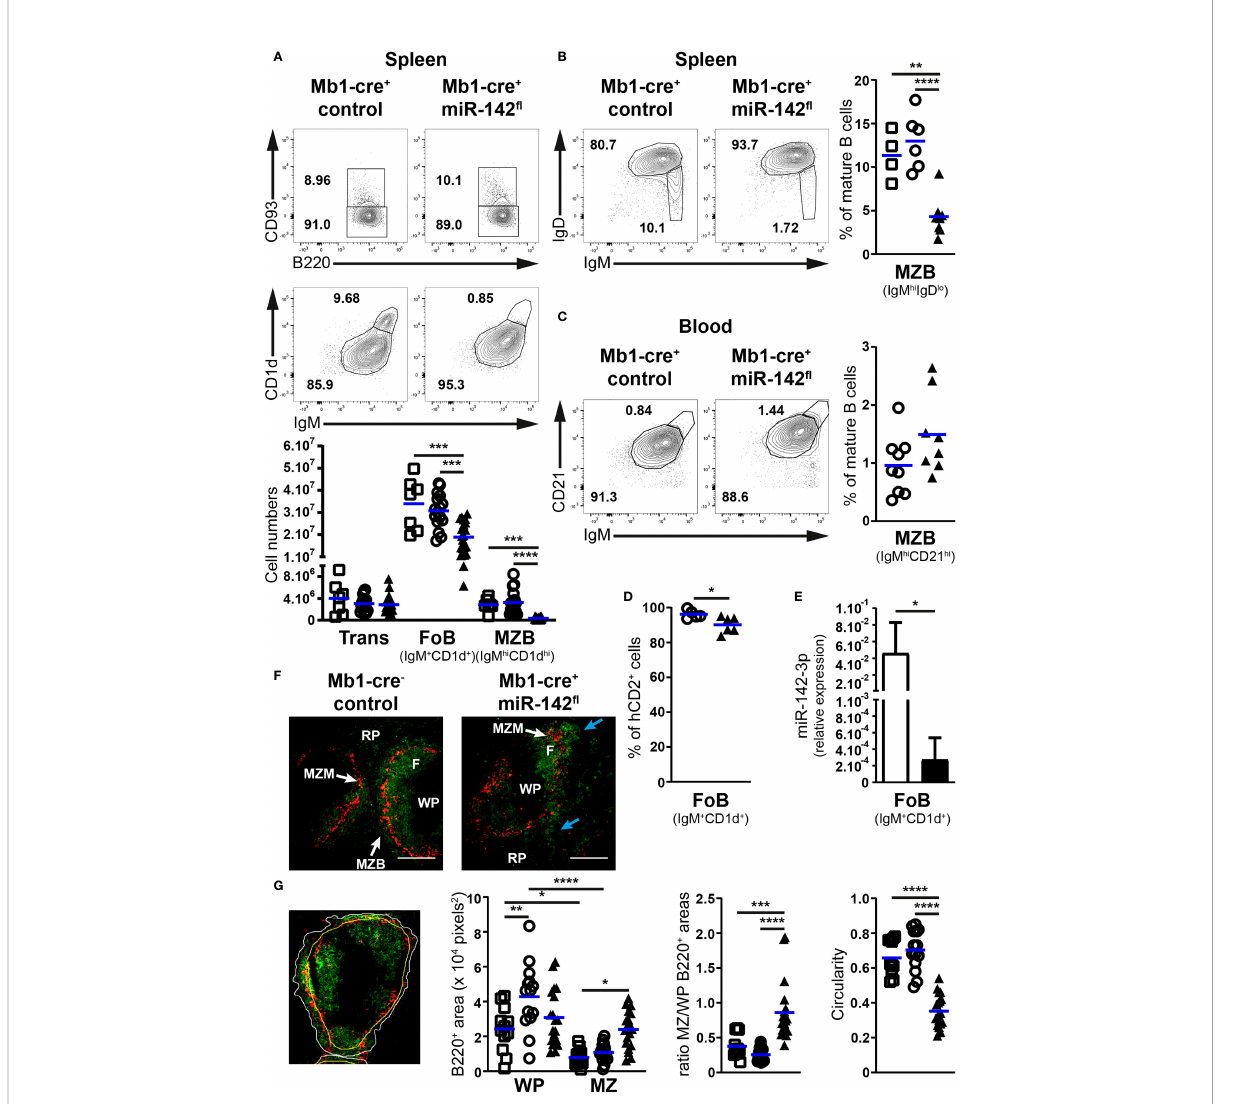
FIGURE 2 The mature B cell compartment is perturbed in the spleens of Mb1-cre + miR-142 fl mice. (A) Top: FACS analysis of B220 + CD93 + transitional and B220 + CD93 – mature B cells within splenic CD19 + B220 + B cells, as well as IgM + CD1d + follicular and IgM hi CD1d hi marginal zone B cells within mature B cells of Mb1-cre + control and Mb1-cre + miR-142 fl animals. Bottom: Transitional (Trans), follicular (FoB) and marginal zone (MZB) B cell numbers in the spleens of Mb1-cre – ( □ ), Mb1-cre + ( ○ ) and Mb1-cre + miR-142 fl ( ▲ ) mice. n = 7-21 per group in 21 independent experiments. (B) Left: fl ow cytometry of IgM + IgD + follicular and IgM hi IgD lo marginal zone B cells within splenic CD19 + B220 + CD93 – mature B cells of control and mutant mice. Right: splenic MZB cell frequency in the mouse groups de fi ned in (A) . n = 4-8 per group, cumulative of 9 independent experiments. (C) Left: FACS analysis of IgM + CD21 + follicular and IgM hi CD21 hi marginal zone CD19 + B220 + CD93 – mature B cells in the blood of control and mutant mice. Right: proportions of MZB cells in the blood of Mb1-cre + ( ○ ) and Mb1-cre + miR-142 fl ( ▲ ) animals. n = 8-9 per group, cumulative of 9 independent experiments. (D) Proportions of hCD2 + Fo B cells in the spleen of Mb1-cre + ( ○ ) and Mb1-cre + miR-142 fl ( ▲ ) mice, as determined by fl ow cytometry. n = 5-6 per group, pooled from 6 independent experiments. (E) Real-time PCR of miR-142-3p levels in fl ow cytometry-isolated splenic IgM + CD1d + follicular B cells from Mb1-cre – and Mb1-cre + miR-142 fl mice, normalized to the expression of RNA U6. n = 4 per group in 3 independent FACS sorts. (F) Immuno fl uorescence confocal microscopy of CD169 + (red) macrophages and B220 + (green) B cells in spleens from Mb1-cre – control and Mb1-cre + miR-142 fl mice. Illustrative of 2 Mb1-cre – , 3 Mb1-cre + and 5 Mb1-cre + miR-142 fl animals in 4 independent experiments. F, follicle; MZM, marginal zone macrophages; MZB, marginal zone B cells; RP, red pulp; WP, white pulp. Blue arrows, irregular distribution of mutant B cells in the MZ. Magni fi cation, 10x. Scale bar, 200 m m. (G) Left: Identi fi cation of the perimeter (white) of the B cell population in the marginal zone, of the CD169 + macrophage ring (yellow) and of B220 signals (green), as illustrated in an immuno fl uorescence image of a Mb1-cre + control mouse. Right: B220 + areas within the white pulp (WP) and the marginal zone (MZ), ratios of the B220 + areas in the MZ and WP, as well as the circularity of the B cell perimeters in 12-19 selected fi elds of spleen sections from the groups of mice mentioned in (A) . (A – D) Each symbol depicts one mouse. Means are indicated by horizontal blue lines (A – D) , as well as bars plus standard deviations (E) . *, P ≤ 0.05; **, P ≤ 0.01; ***, P ≤ 0.001; ****, P ≤ 0.0001 by one-way ANOVA (A, B, G) and Student ’ s t test (C – E)